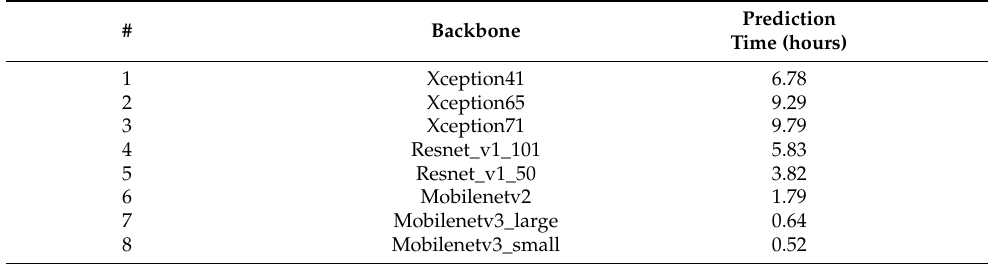
Table 5. Computational time for prediction within three study areas using RGB and nirGB images.